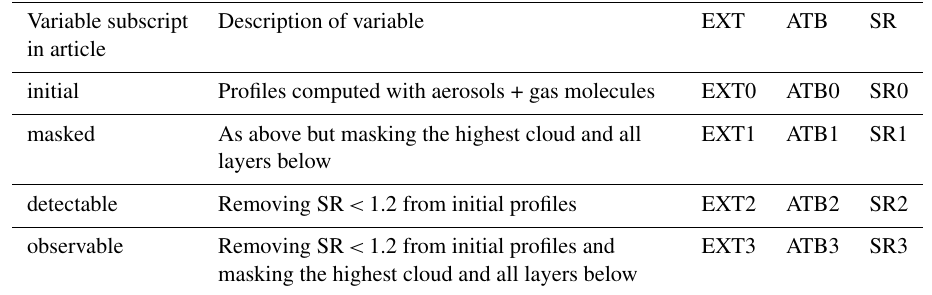
Table 1. Translations between the name of the variables in the text and in the code. For example, EXT_initial in the paper corresponds to EXT0 in the